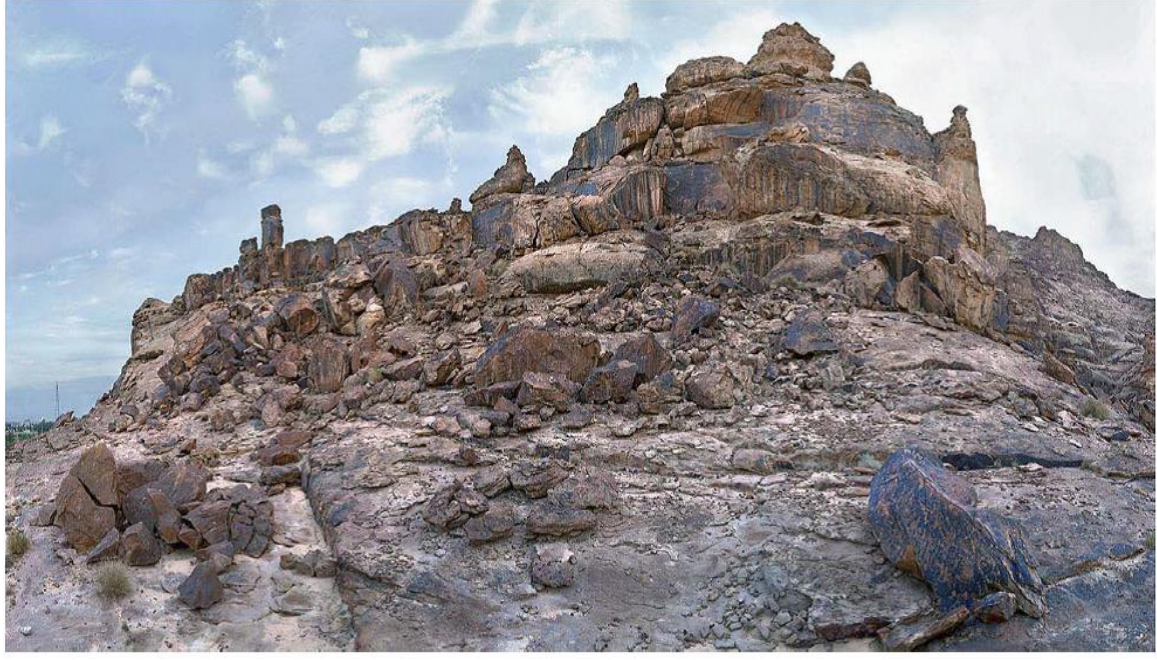
Figure 18. The prehistoric artist choose this smooth vertical surface of a large boulder to create one of the most fascinating and outstanding work of art. When the sun rays fell at dawn on this east-facing rock art panel, the figures become shining and reflective, and in a moon-lit night, the entire rock shines like a bowl of light creating a strange, calm, and soothing atmosphere. On a calm, moonlit night, when one stands in front of the rock, one can feel as if someone is playing the rubab . The female figure, with prominent sexual traits, radiating hair, the crescent-shaped motif near the head, and apparently various phases of moon marked on her body, is in a standing posture with half-raised arms, while a man looking at the girl who is playing the rubab (a traditional Arab musical instrument still used by the Bedouins). The panel is unique, located in a very remote, rugged, isolated, and hardly accessible area in Najran, southern region. There is a considerable time difference between the superimposed inscriptions and the human figures, which are older than the later